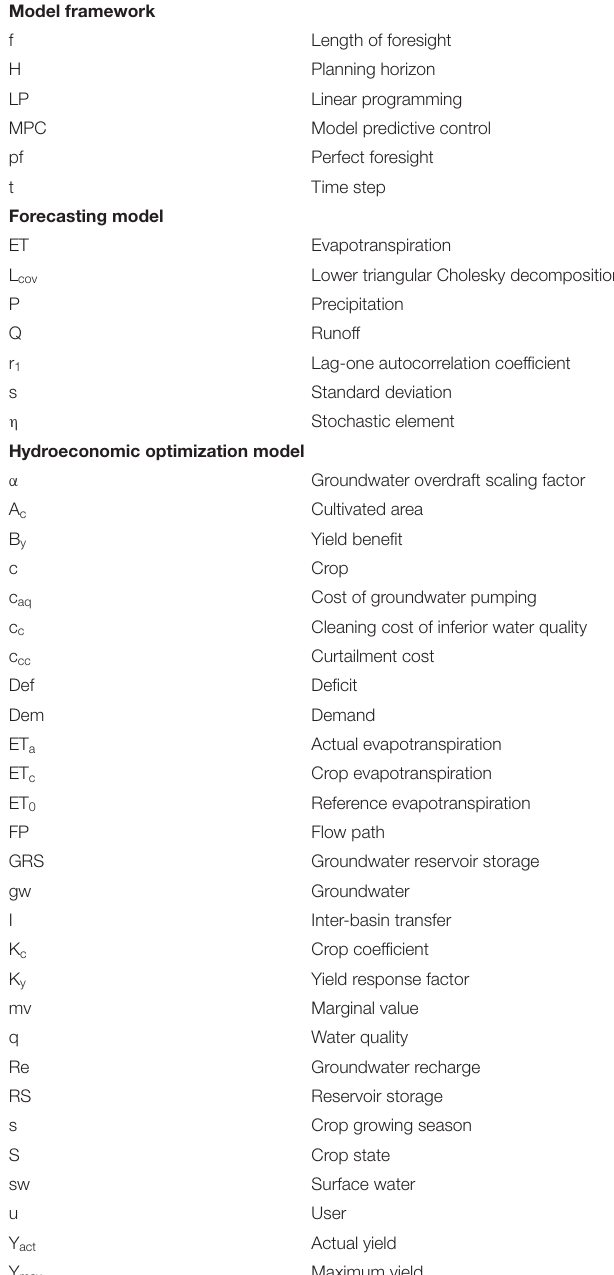
TABLE 1 | List of acronyms and abbreviations used in the